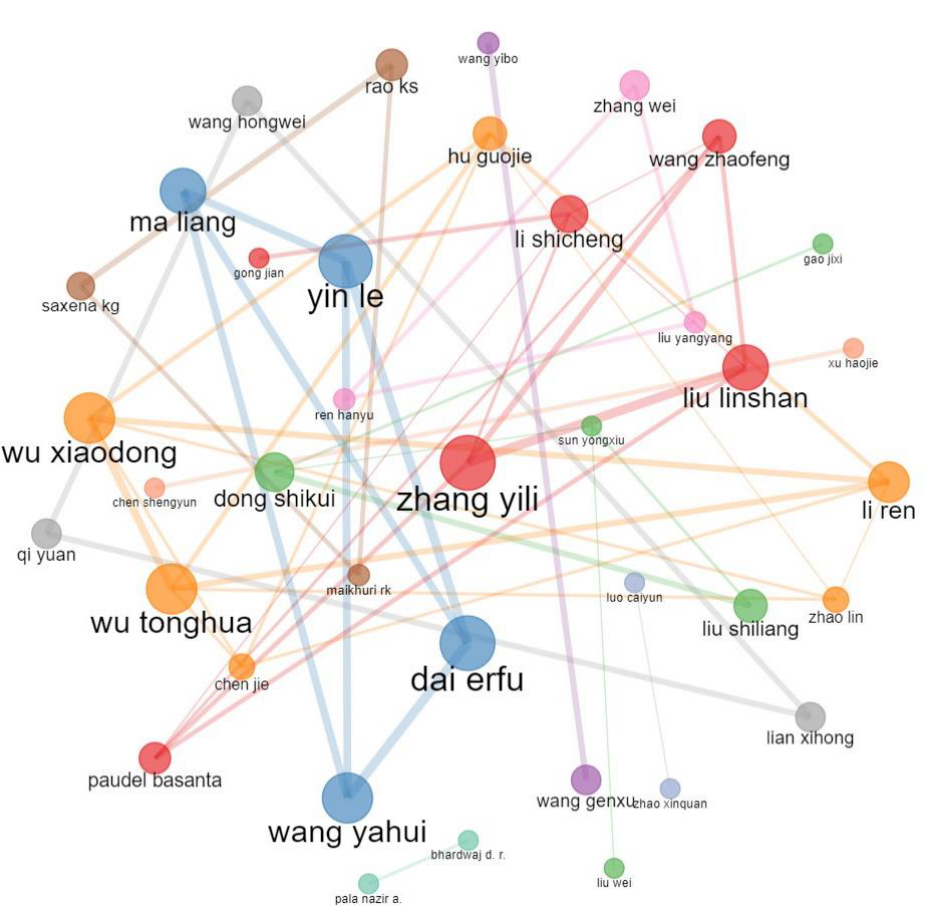
Figure 6. Co-authorship network map of researchers having considered the ecological and environmental effects of land use and cover changes (LUCC) on the Qinghai – Tibetan Plateau (QTP).